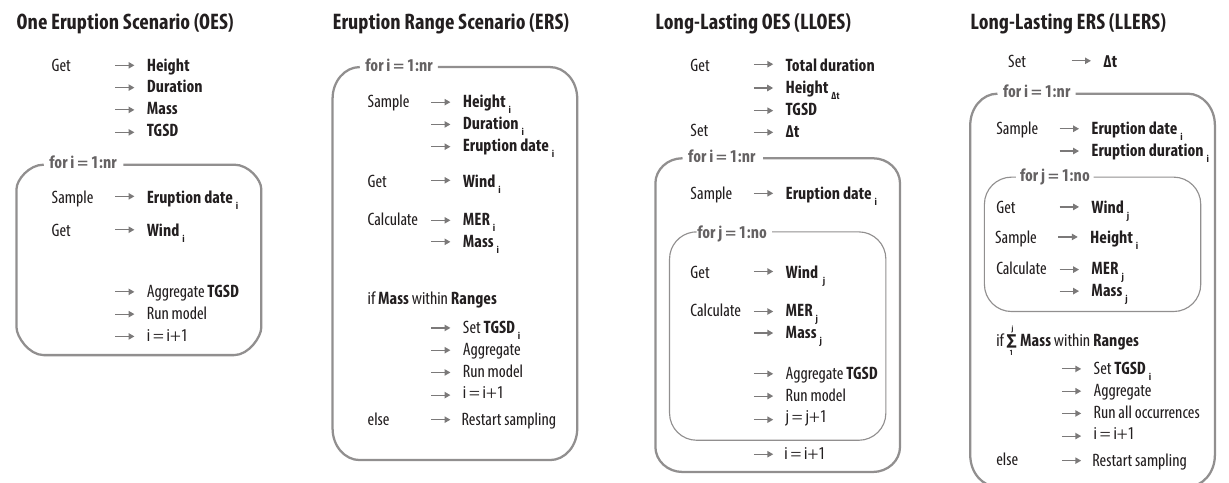
Figure 2. Algorithms applied for the different eruption scenarios used in this study. Get refers to access to deterministic data, Set defines a variable and Sample indicates a stochastic